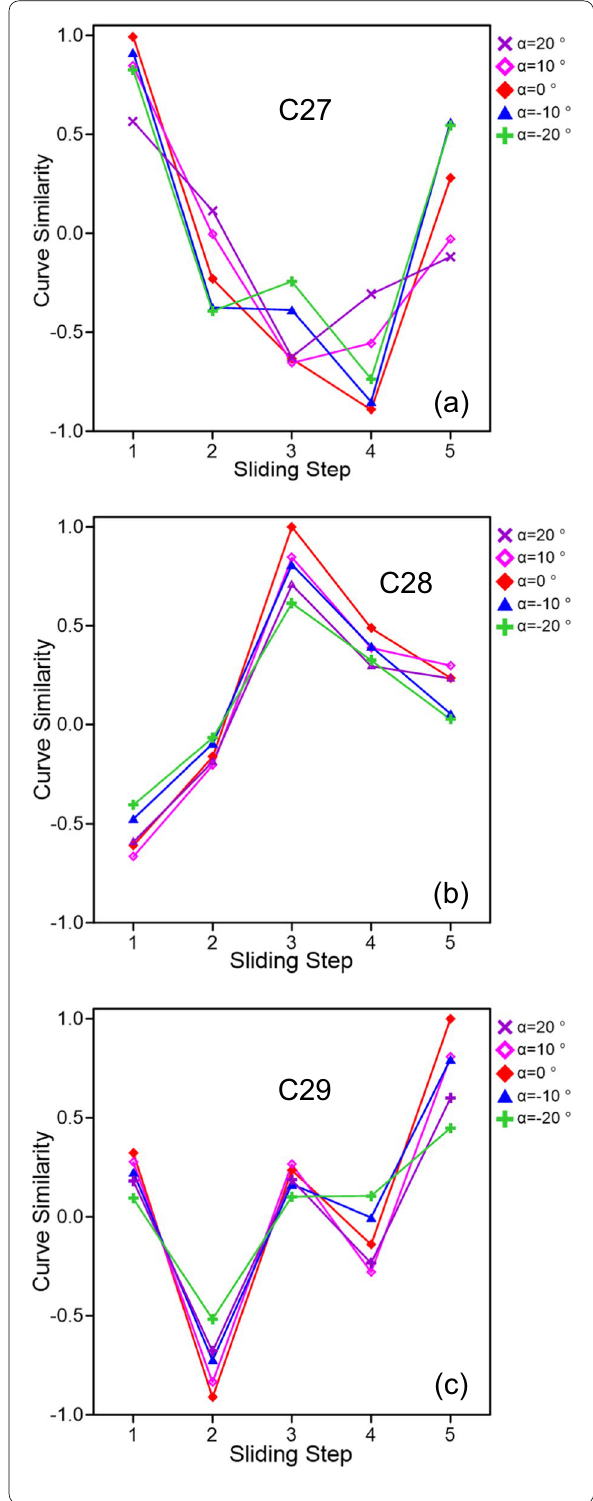
20°, 10°, 0°, 10°, 20°. a The − −